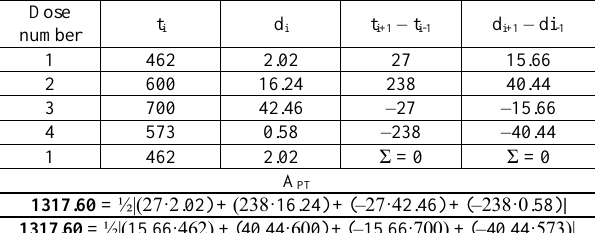
Table 3. Calculation of the resultant fuel metering field A PT